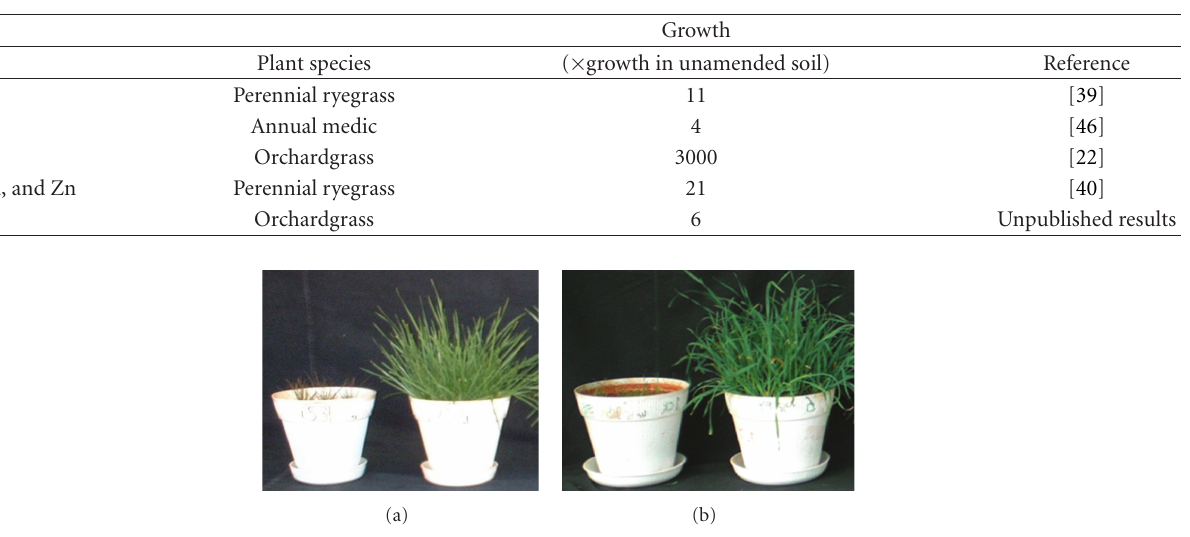
Table 4: Relative growth of several cultivated species grown in soils contaminated with metals.